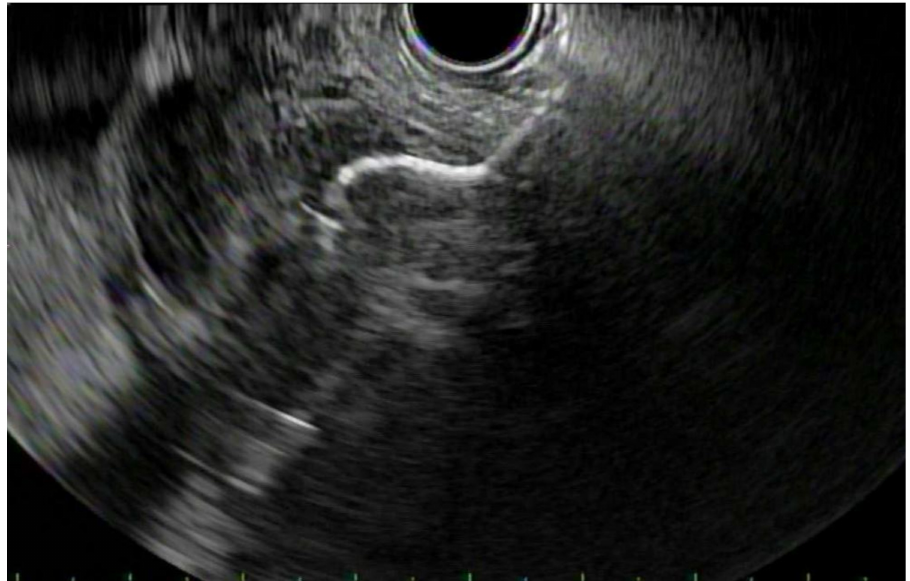
Figure 4. EUS-Gallbladder Drainage (EUS-GLB): Endosonographic image of a lumen-apposing metal stent being deployed between the gallbladder and the